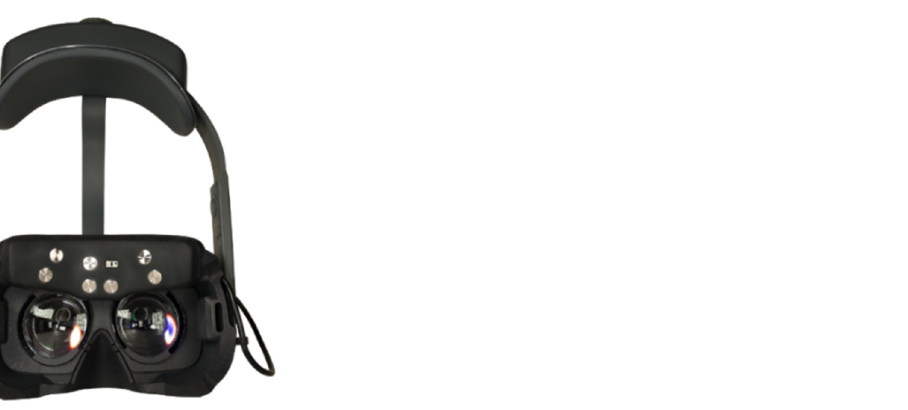
Figure 3. The emteqPRO Mask installed into the Pico Neo 2 Eye Virtual Reality (VR) headset.